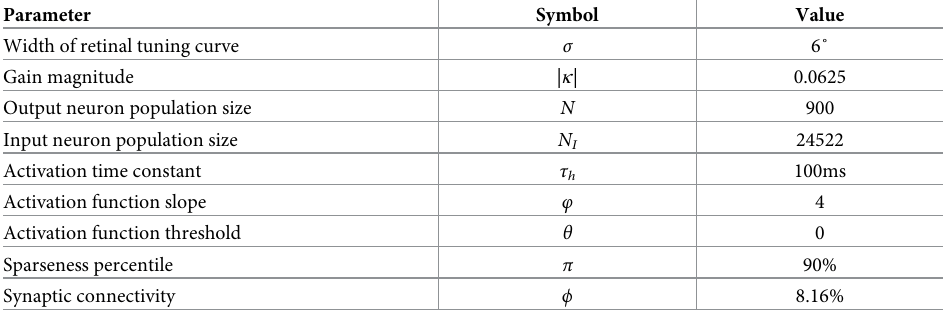
Table 2. Simulation parameters of the network model that has been manually prewired in order to produce head- centred output neurons with monotonic modulated input neurons.